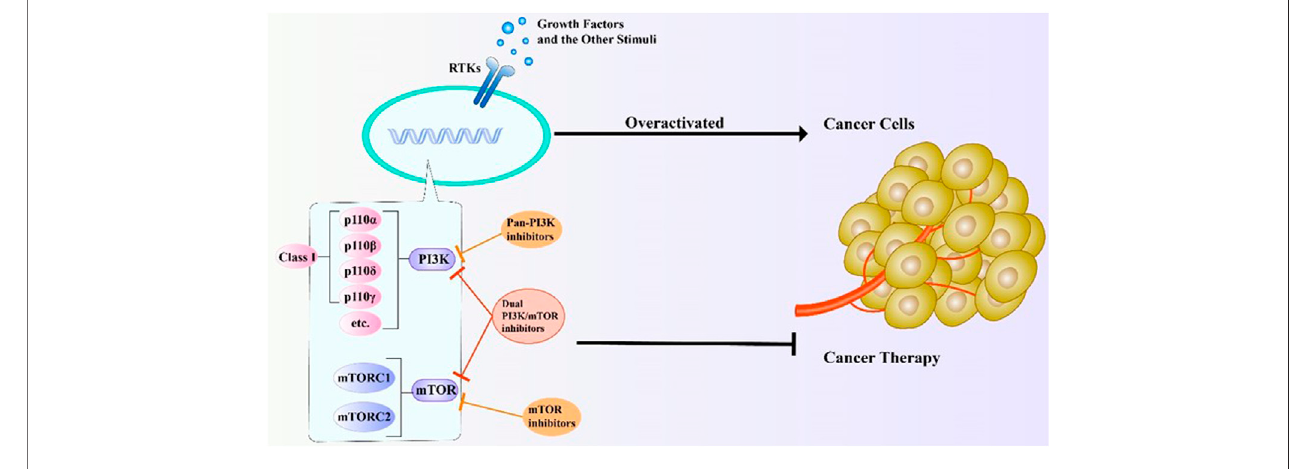
FIGURE 1 | PI3K-Akt-mTOR signalling pathway and relationships of several related signalling pathways.